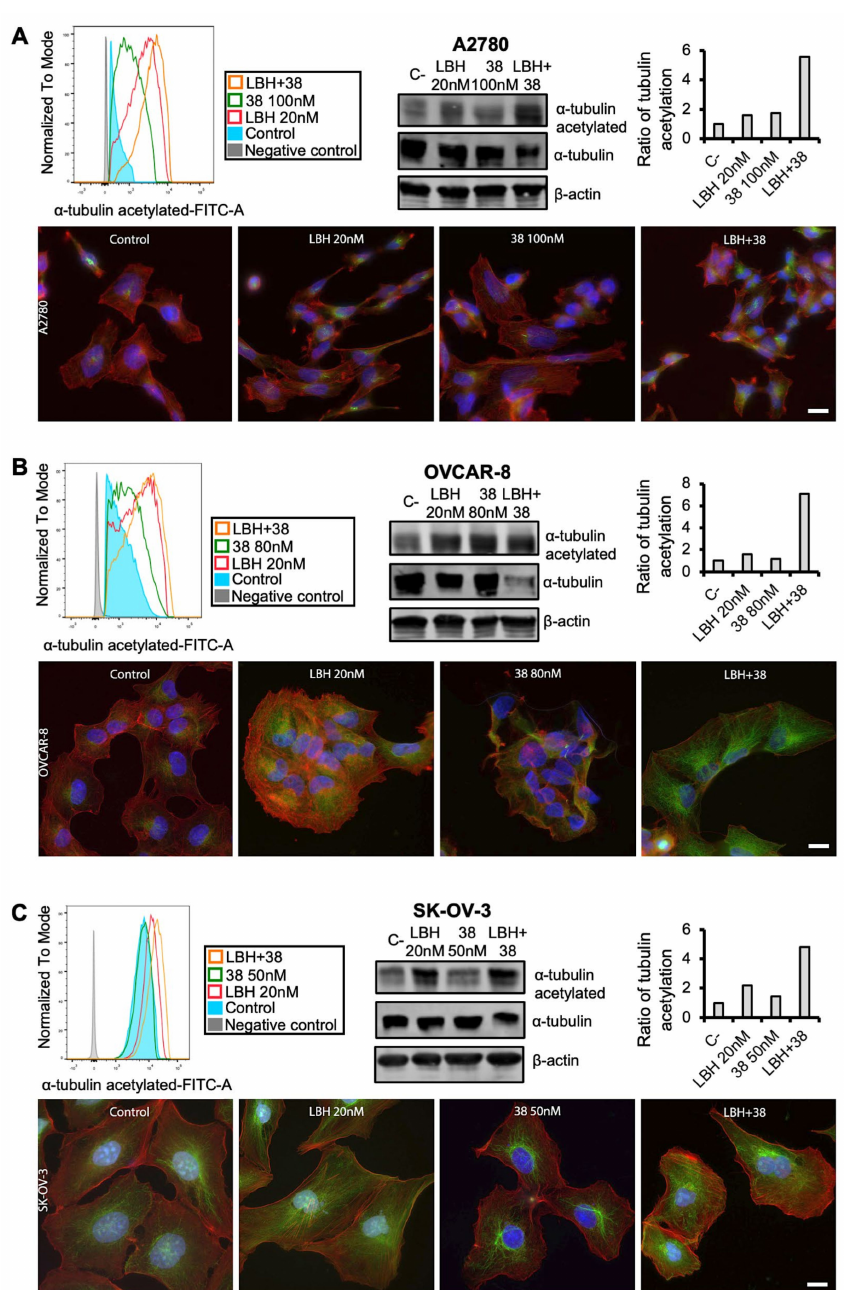
Figure 7. The combination of LBH and 38 induces increases α -tubulin acetylation. ( A ) A2780, ( B ) OVCAR-8 or ( C ) SK-OV-3 cell lines were treated with the indicated for 24 h and the acetylation of α -tubulin was detected by flow cytometry ( left panel ), western blot ( right panel ), and immunofluo- rescence ( bottom panel ). β -actin was used as a loading control. Protein levels were quantified using ImageJ. Graphs represented the normalized ratios of acetylated α -tubulin over total α -tubulin, using β -actin levels to normalize. Untreated cells (C-) levels were taken as 100. Acetylated tubulin is shown in green and actin in red. Nuclei were stained with Hoechst (blue). Scale bar: 10 µ